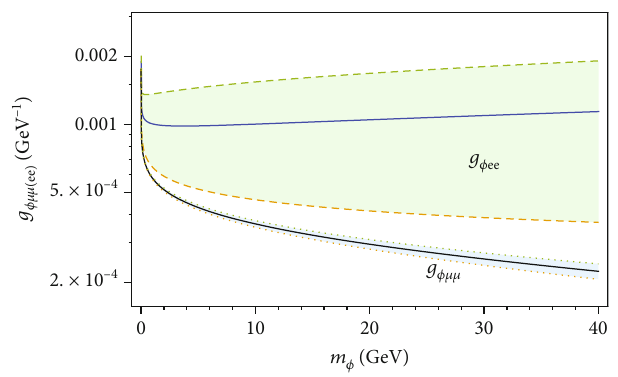
Figure 2: The 2 σ allowed region for e (green) and μ (blue) of the parameter space for the pseudoscalar solution assuming g ϕγγ = − 0 : 05 GeV − 1 . The lack of any overlap between the favored regions for the electron and the muon indicates that we cannot have a solution where Equation (4) is valid. Therefore, the pseudoscalar solution is